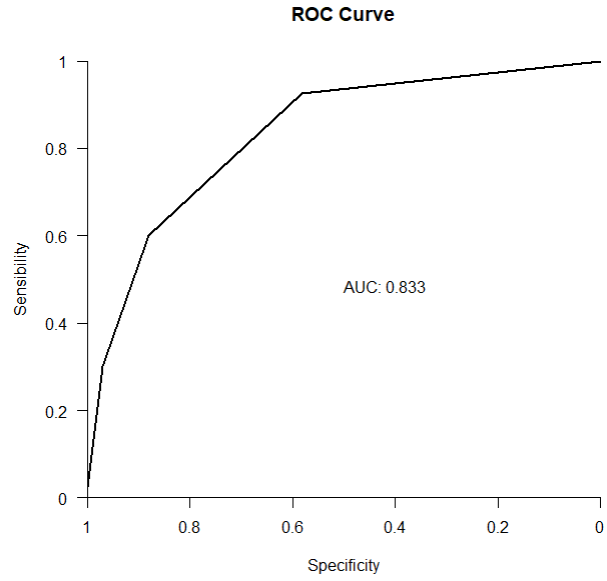
Figure 1. ROC curve, “sZFS” vs. GFST.